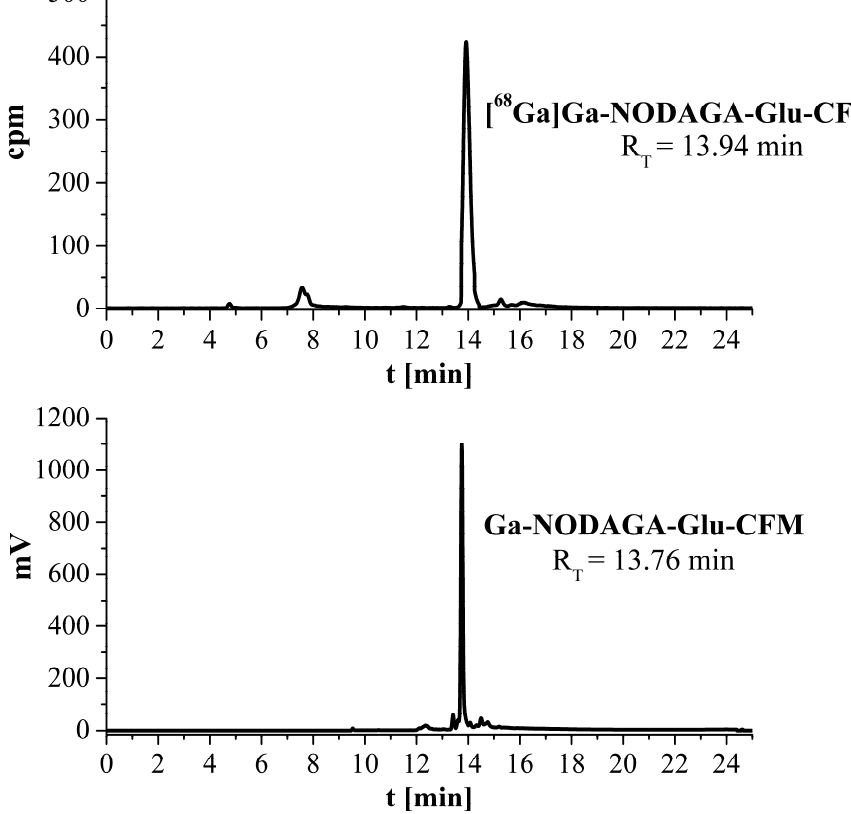
Figure 8. HPLC analysis of reaction mixtures after synthesis of [ 68 Ga]Ga-NODAGA-Glu-CFM (gradient 2) and the ‘cold’ reference compound Ga-NODAGA-Glu-CFM (270 nm, gradient 2). MS for C 39 H 52 GaN 10 O 15 S 2+ , TOF MS ES + m / z : (calculated: 1033.23); found: